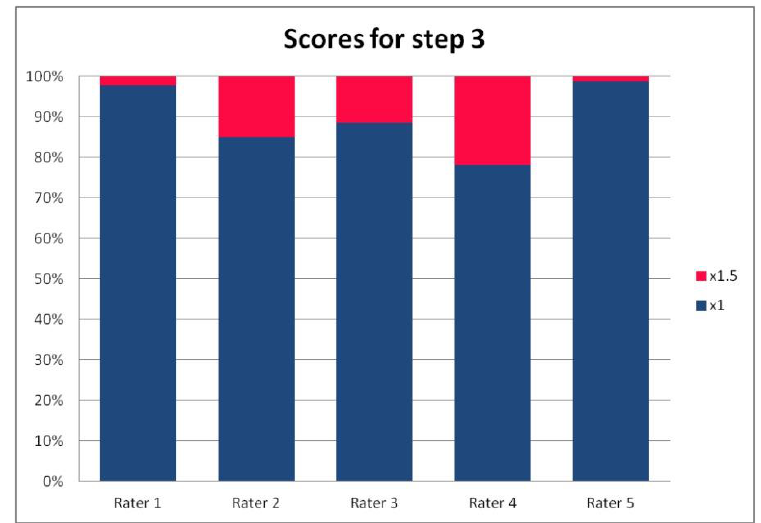
Figure 4. The percentage of ratings in the available categories given by individual raters for step 3 of the PRAETORIAN score.